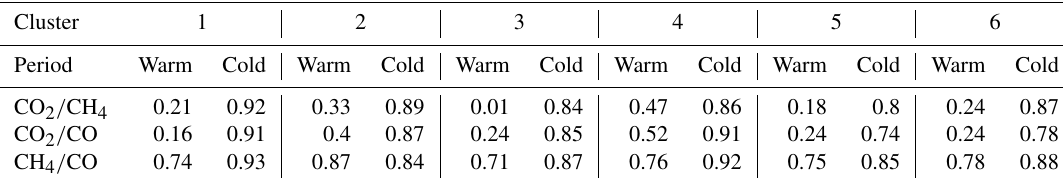
Table 8. Correlation coefficients between the compound residuals for each cluster, split between a warm period from April to September and a cold period from October to